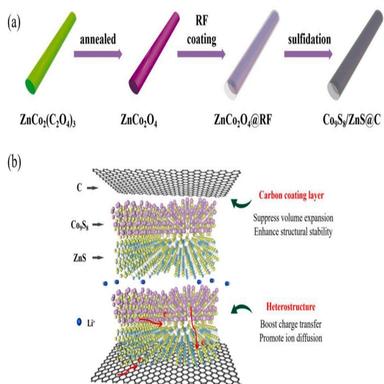
(a) The illustration of the formation and the schematic diagram of the Co9S8/ZnS@C composite; (b) Schematic diagram of the Co9S8/ZnS@C composite.